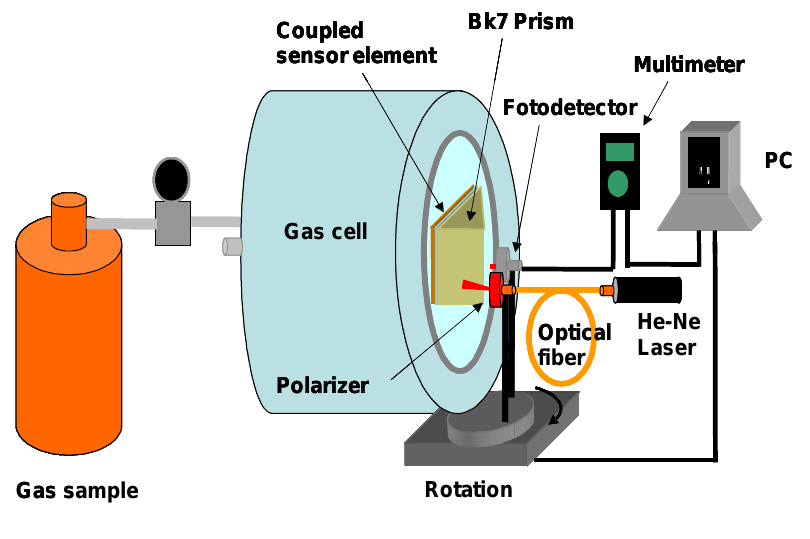
Figure 5. Experimental set up for the SPR sensor